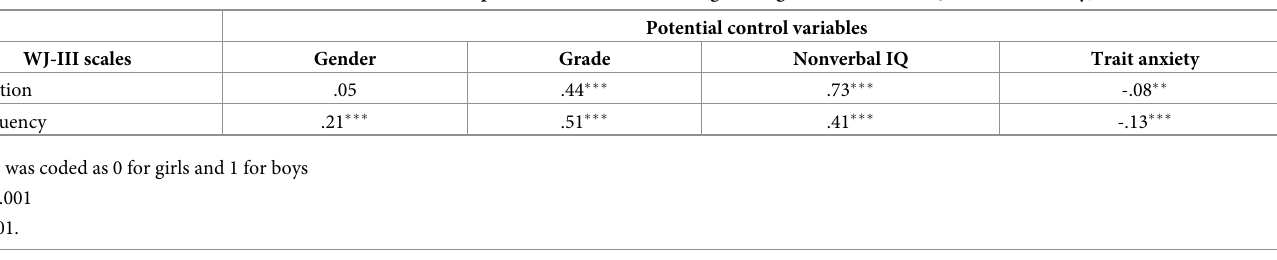
Table 3. Zero-order correlations between WJ-III scale scores and potential control variables (gender, grade, nonverbal IQ, and trait anxiety).